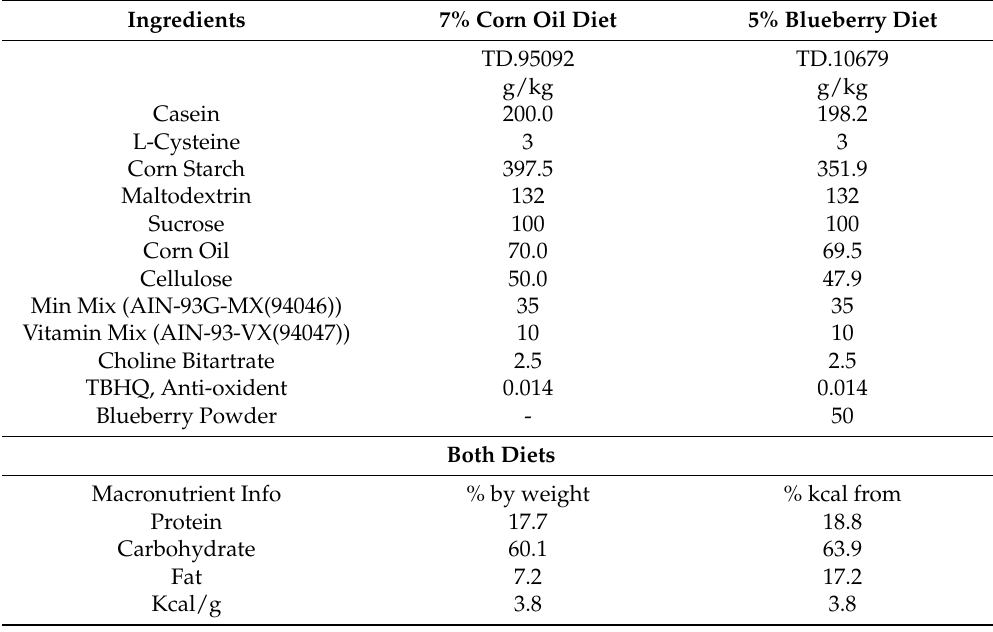
Table 1. The diet compositions, showing the weight (g/kg), % by weight, and % by kcal of the dietary